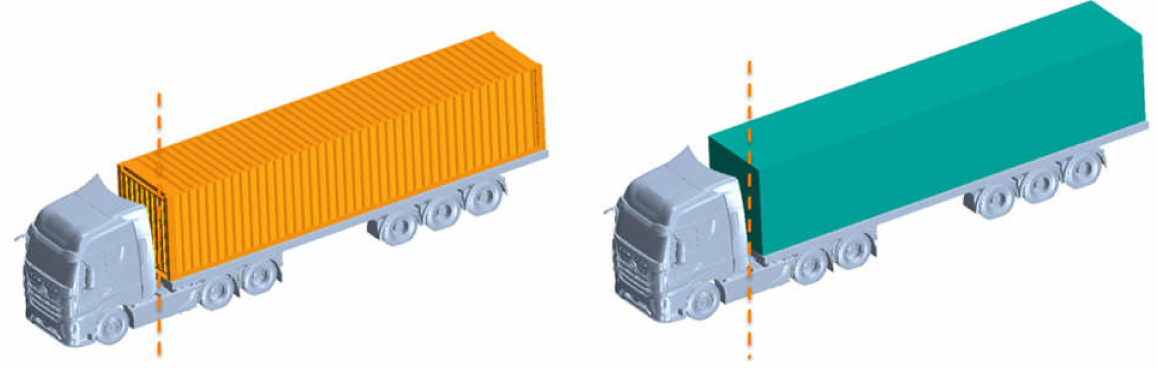
Figure 2. CAD model of the commercial vehicle